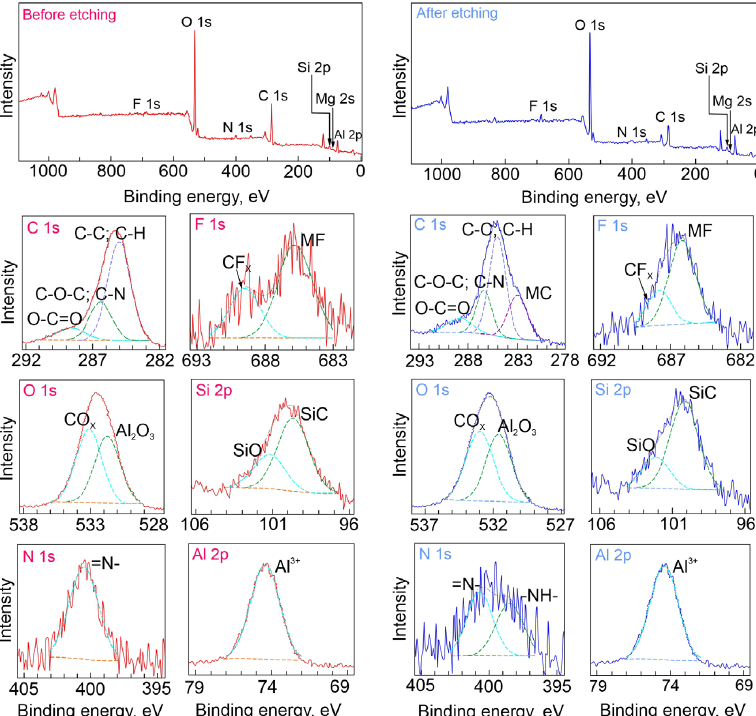
Figure 4. XPS spectra obtained for a sample with 1,2,4-triazole containing composite coating (0.05 M) and the detailed high resolution spectra before and after Ar + etching. Table 1. Binding energy (eV) and elemental composition (at. % in parentheses) of the surface of CC - 1,2,4 - tr - 24 sample .